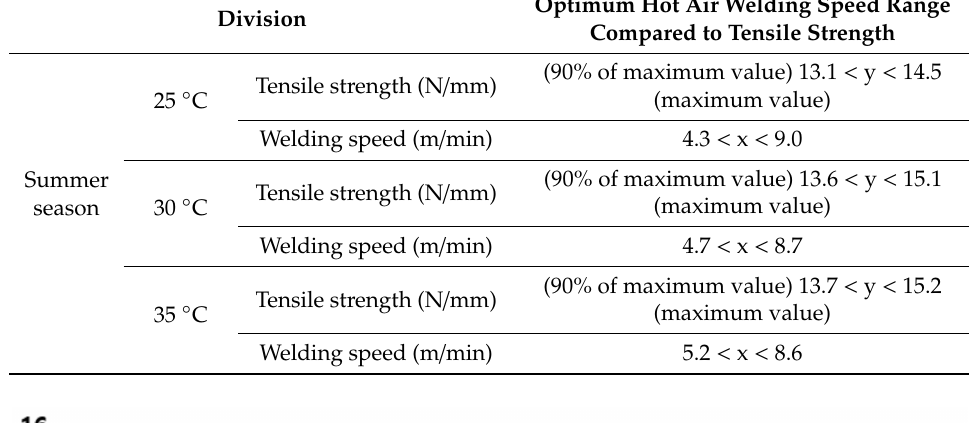
Table 10. Optimum hot air welding speed range compared to joint tensile strength in summer.